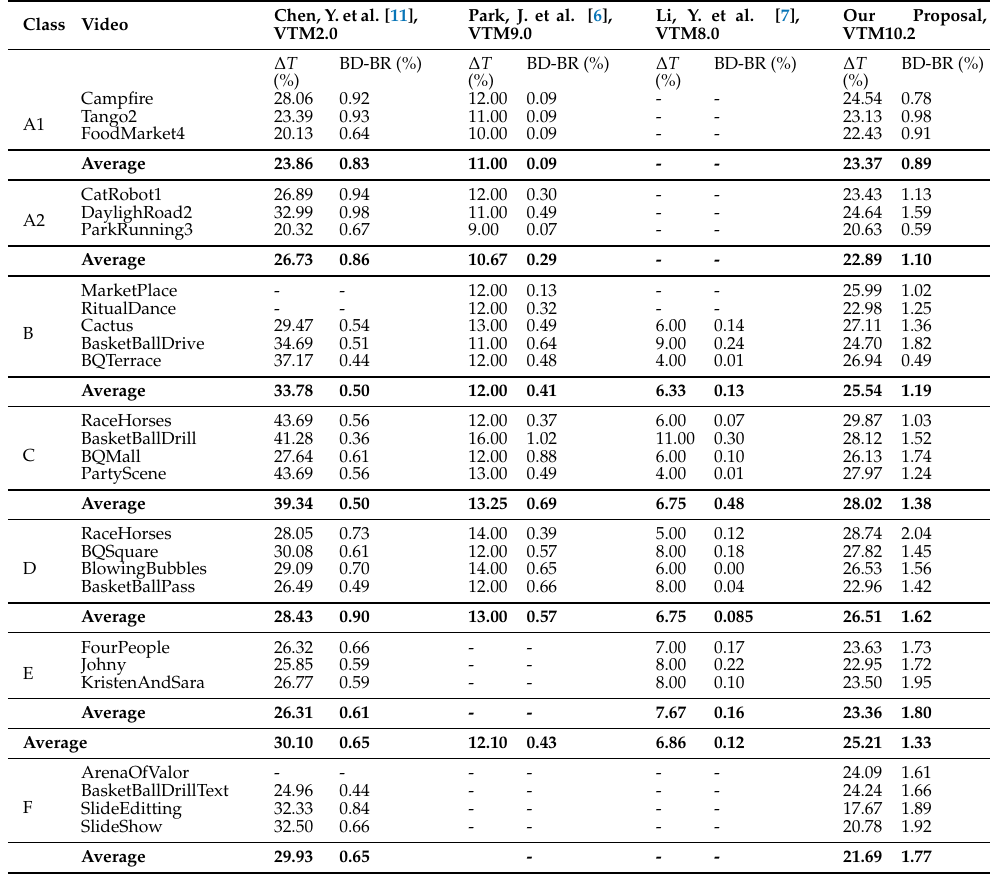
Table 3. Performance of the MT based intra-mode decision framework in comparison with the state-of-the-art